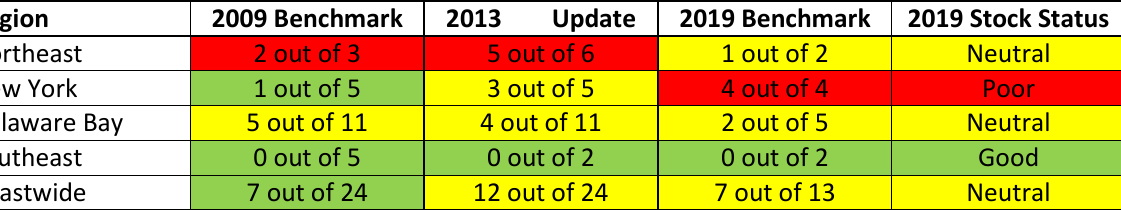
Table 53. Stock status determination for the coastwide and regional stocks based on the 1998 index-based reference points from ARIMA models. Status was based on the percentage of surveys within a region (or coastwide) having a >50% probability of their terminal year fitted value being less than the 1998 index-based reference point. “Poor” status was >66% of surveys meeting this criterion, “Good” status was <33% of surveys, and “Neutral” status was 34 – 65% of surveys. The same criteria were applied to ARIMA results from the 2009 benchmark assessment and 2013 update assessment for comparison purposes. NOTE: The suite of surveys used in each assessment as well as the index values differed between assessments (see Section 7.3 for explanation).